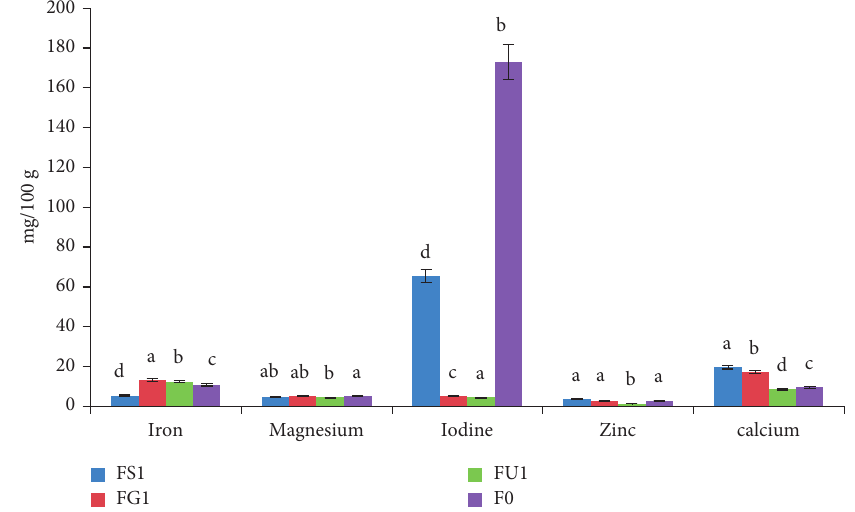
Figure 6: Mineral content of sour fruits with 1.5% algae powder. Different letters indicate significant differences ( p < 0 . 05 )